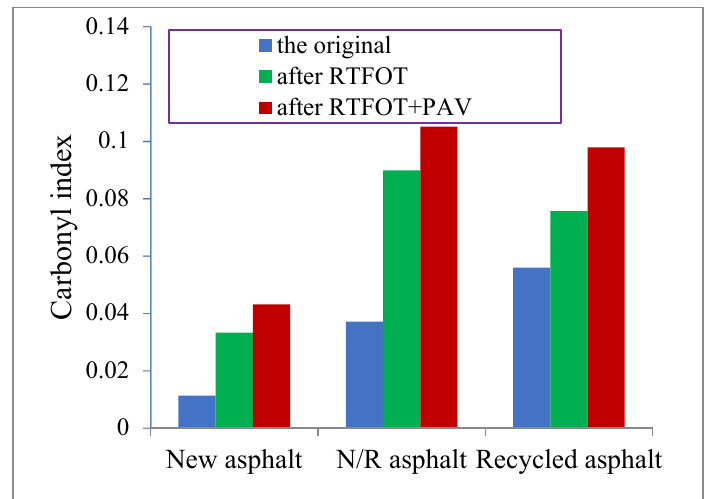
Figure 5. Sulfoxide index of the three asphalts before and after aging.